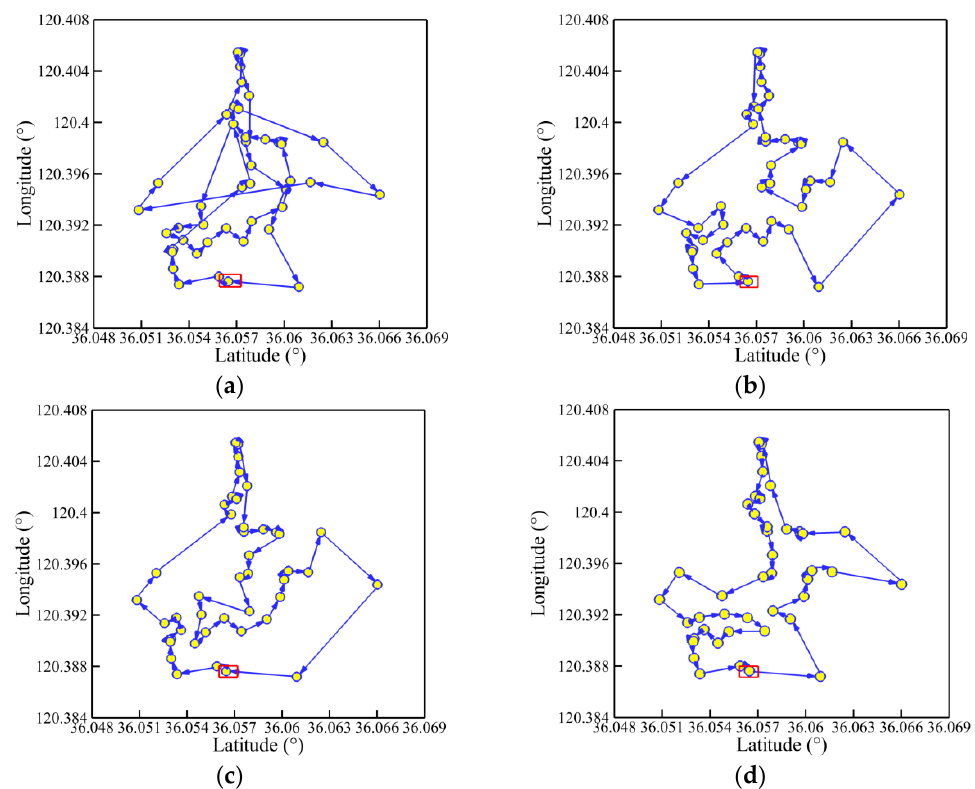
Figure 18. Trajectory planned by each algorithm for P = 45: ( a ) CGA; ( b ) SDIGA; ( c ) DDIGA; ( d )